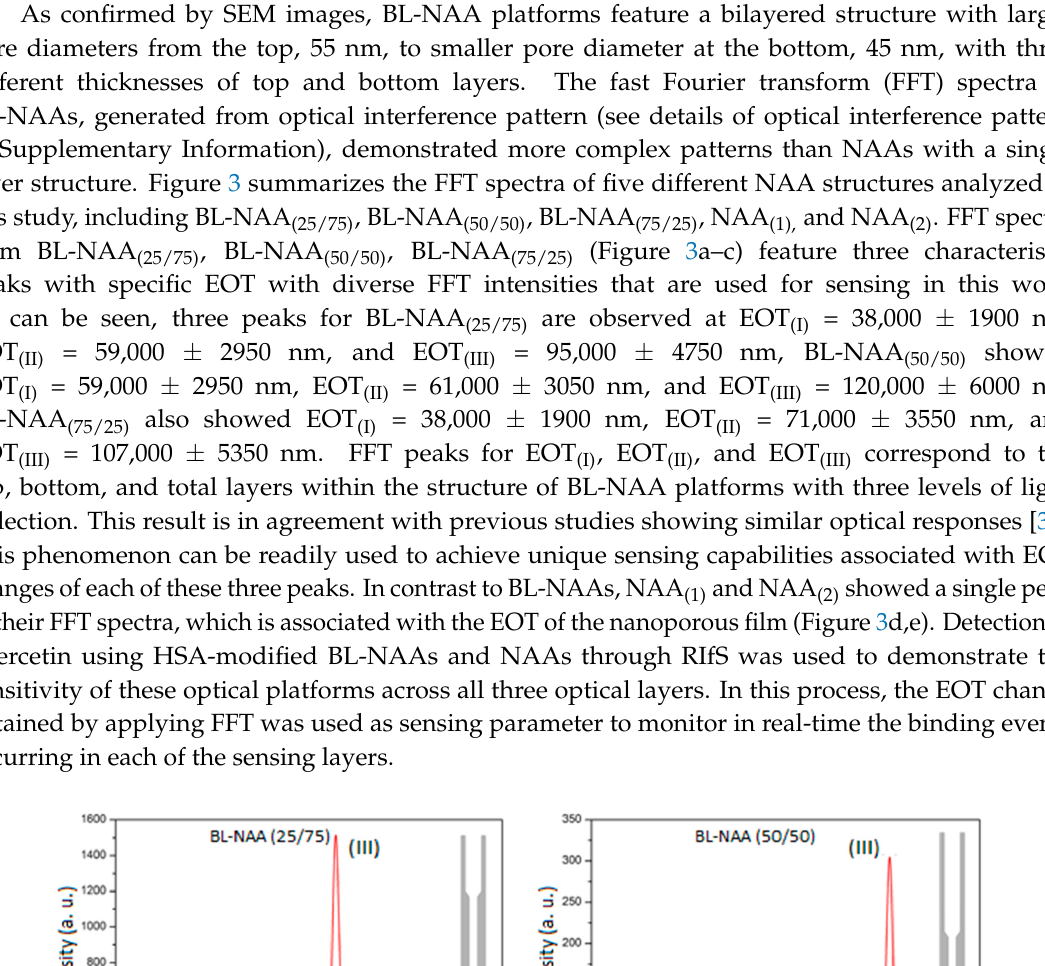
Table 2. Pore dimensions of BL-NAAs and NAAs